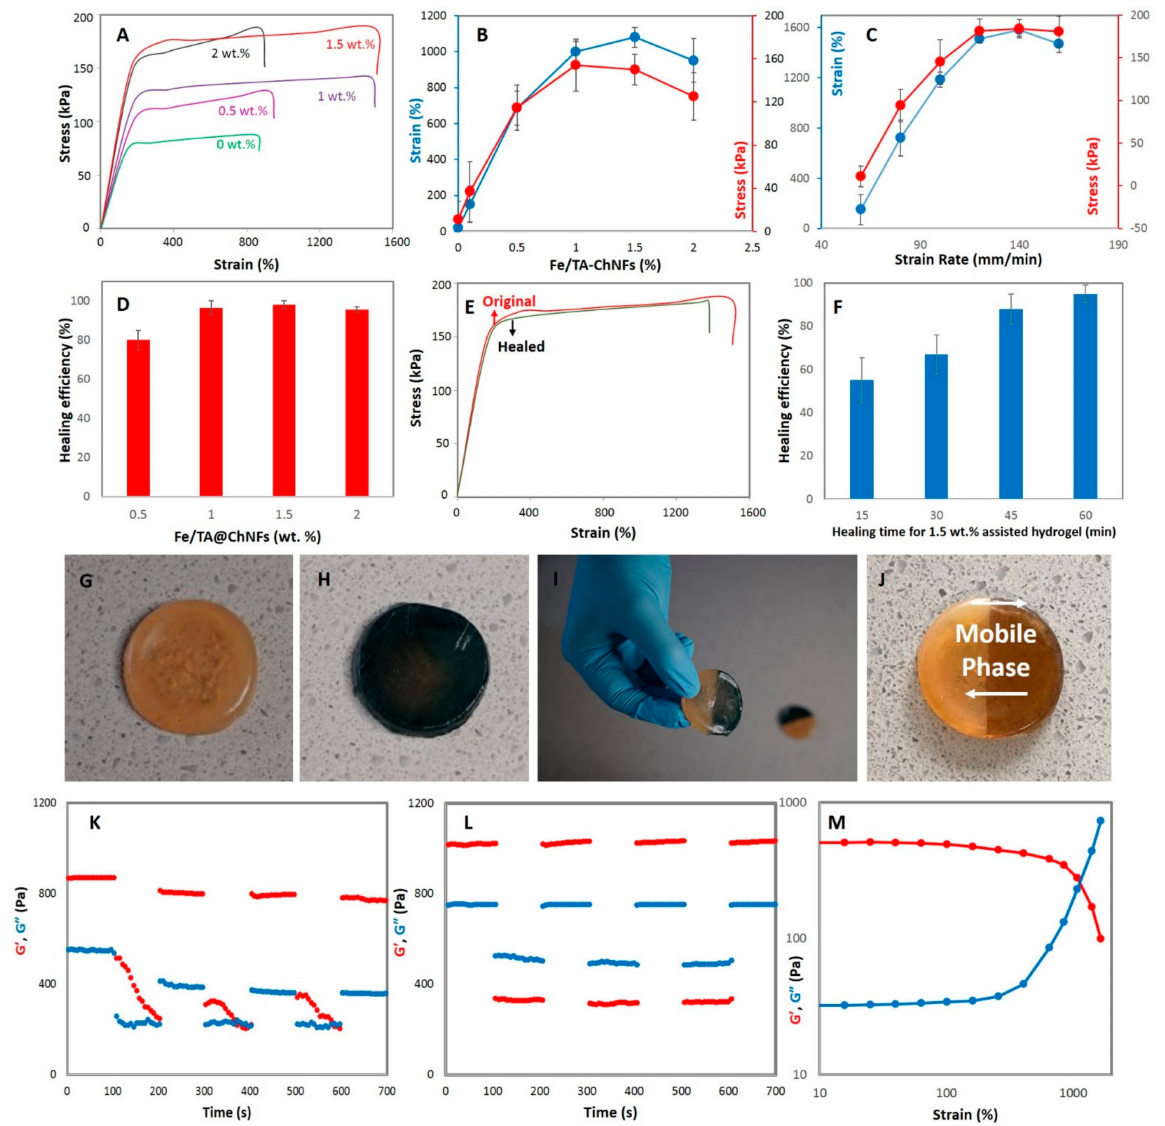
Figure 3. ( A ) Tensile stress–strain curves of the hydrogels at different Fe/TA@ChNF nanohybrid concentrations, ( B ) tensile tests for the notched hydrogels at different Fe/TA@ChNF nanohybrid concentrations, ( C ) tensile test of the hydrogel reinforced by 1.5 wt.% Fe/TA@ChNF nanohybrid at different strain rates, ( D ) healing efficiency of the hydrogels at different Fe/TA@ChNF nanohybrid concentrations, ( E ) typical stress–strain curves of the pristine and healed hydrogels reinforced by 1.5 wt.% Fe/TA@ChNF nanohybrid concentration, ( F ) time-dependency behavior of 1.5 wt.% Fe/TA@ChNF hydrogels during the self-healing process, ( G – I ) visual self-healing inspection of the 1.5 wt.% Fe/TA@ChNF hydrogel, ( J ) the healed hydrogel after 20 min, breakup and reformation ability of ( K ) unreinforced hydrogel and ( L ) 1.5 wt.% Fe/TA@ChNF hydrogel at 1 and 1000% strains and a fixed time interval, and ( M ) shear-thinning behavior of the 1.5 wt.% Fe/TA@ChNF